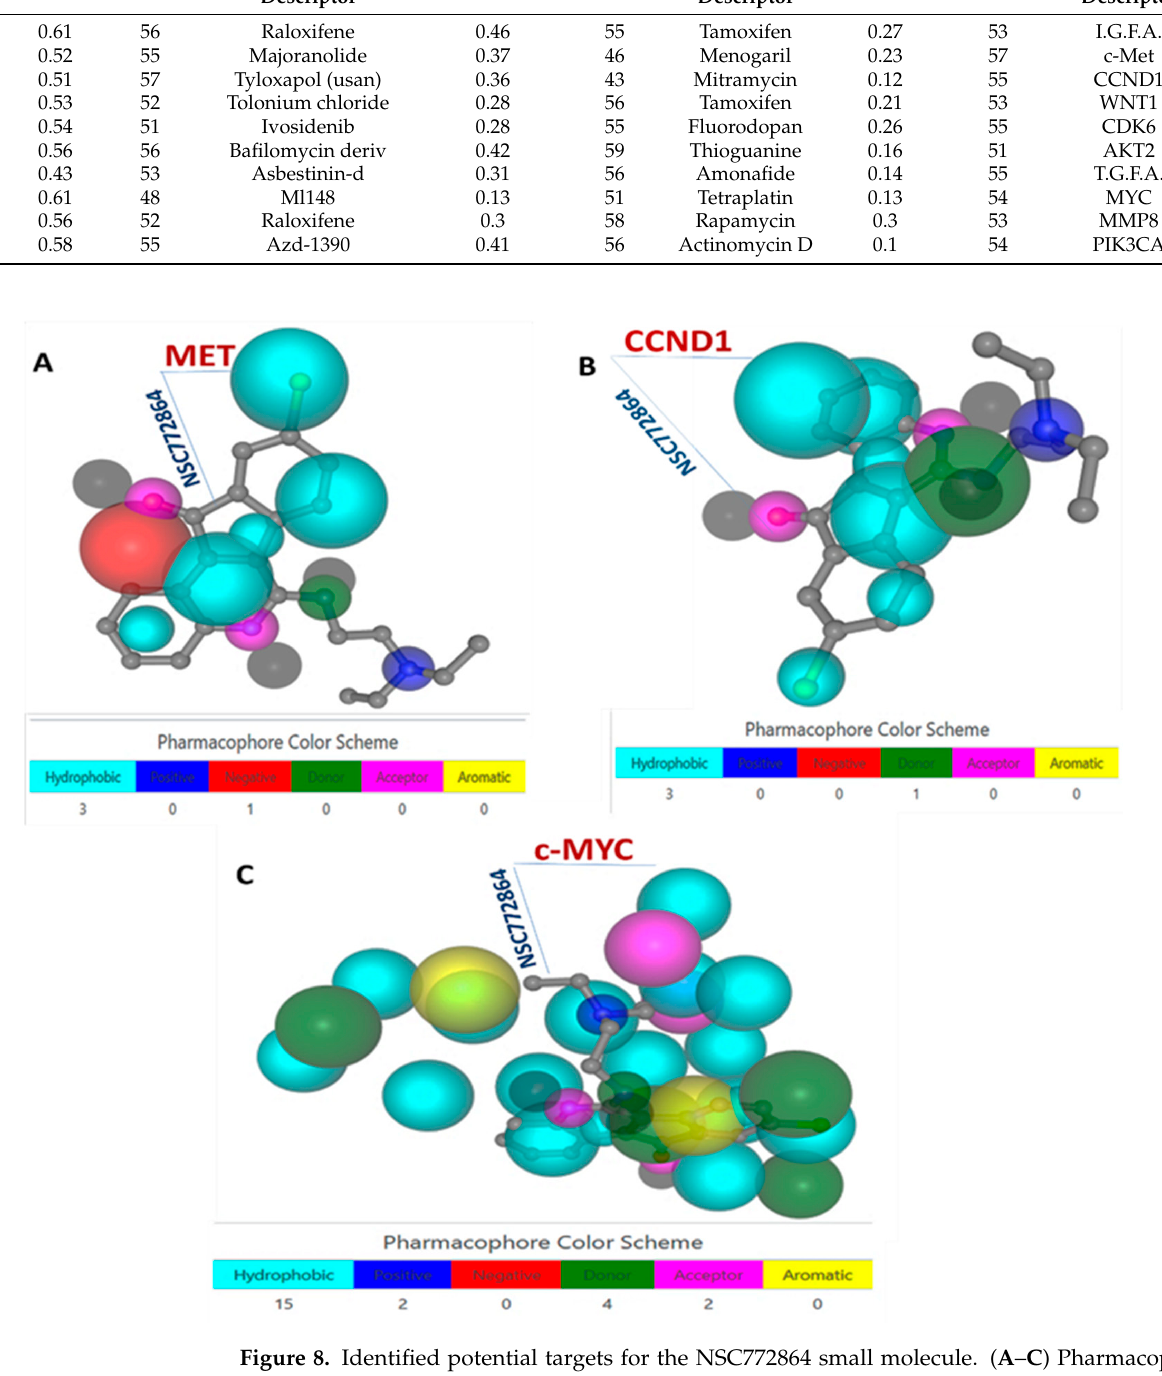
Figure 8. Identified potential targets for the NSC772864 small molecule. ( A – C ) Pharmacophore- based models of c-Met/cMYC/CCND1 identified as NSC772864 target genes through protein– receptor interactions.